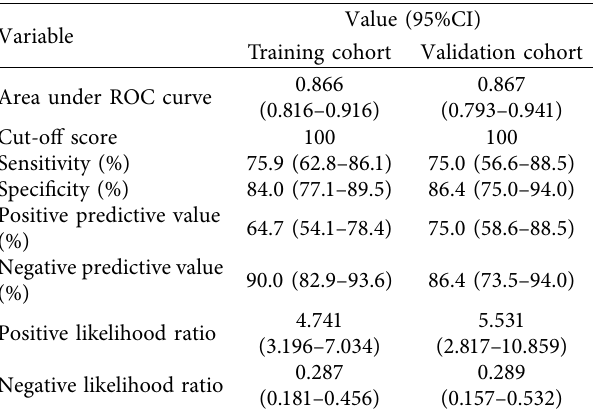
Table 4: Accuracy of the prediction score of the nomogram for estimating the risk of SH